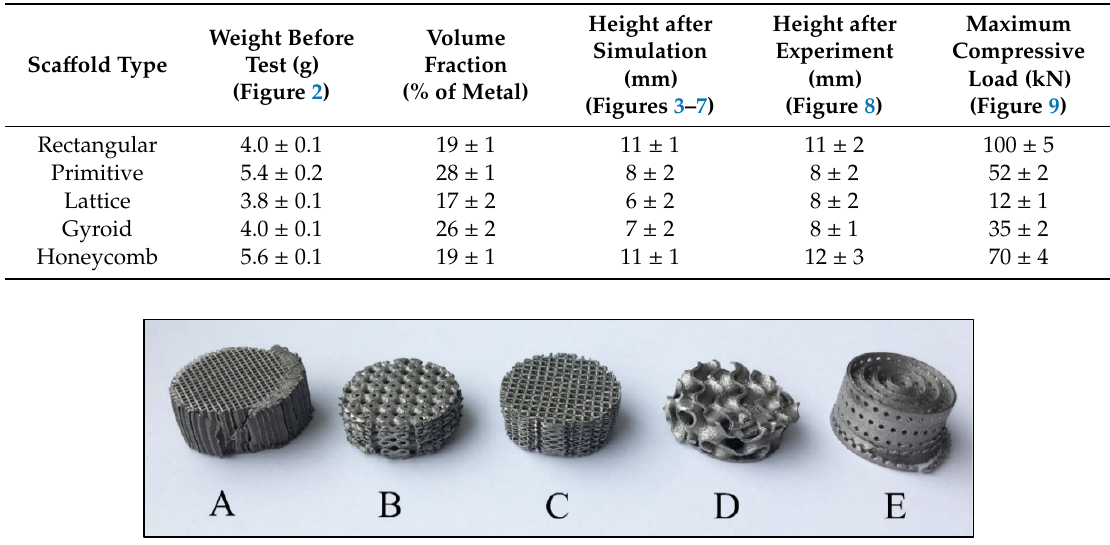
Figure 12. Triply periodic minimal surfaces (TPMS) scaffolds after compressive test with indication of their final height: ( A ) Rectangular − 11 mm, ( B ) Primitive − 8.4 mm, ( C ) Lattice − 8.8 mm, ( D ) Gyroid − 7.6 mm and ( E ) Honeycomb − 12.1 mm.